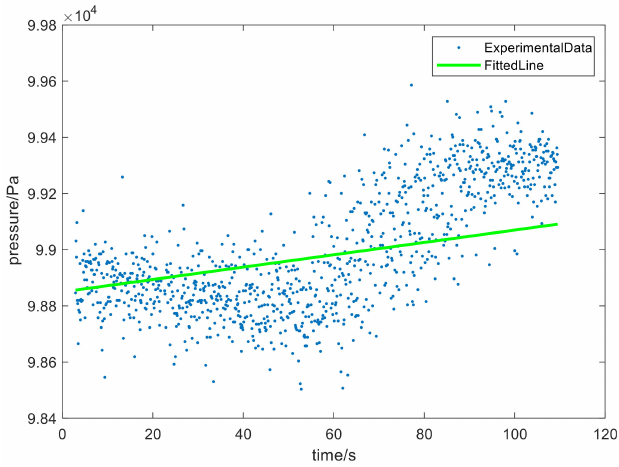
Figure 21. Measured data and fitting curve of pressure sensor